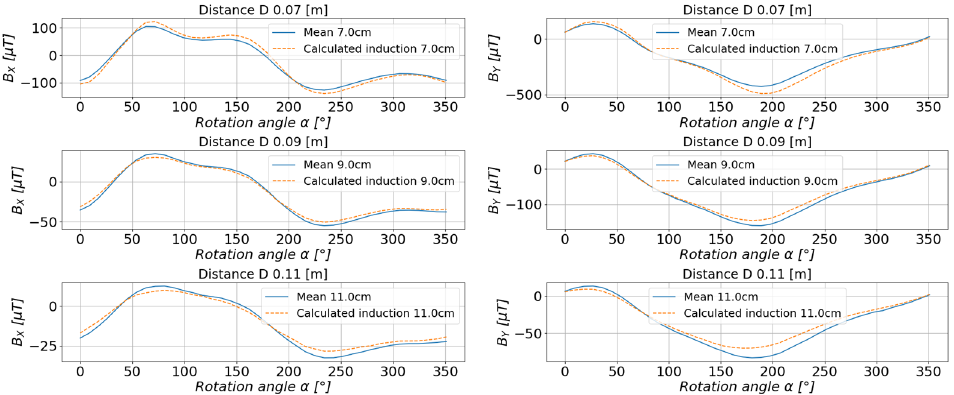
Figure 22. The comparison of the estimated values with the measured values of the magnetic induction in the measurement axis X ( left ) and axis Y ( right ).